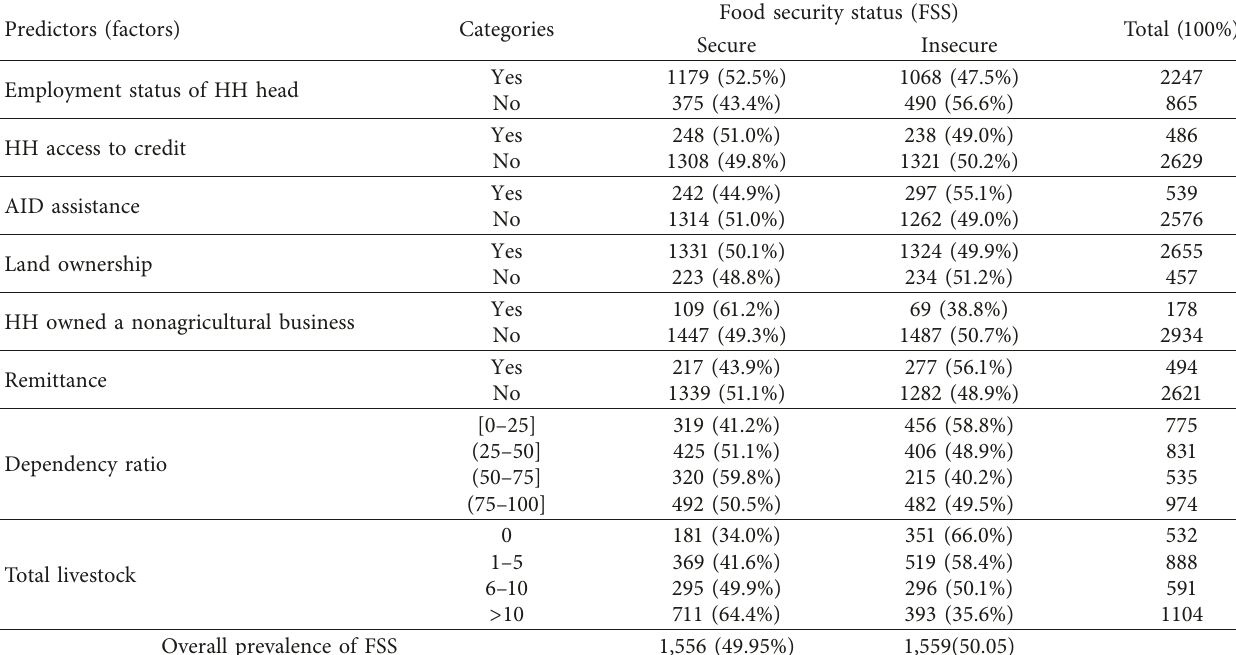
Table 2: Association of household food security status among some socioeconomic variables in rural